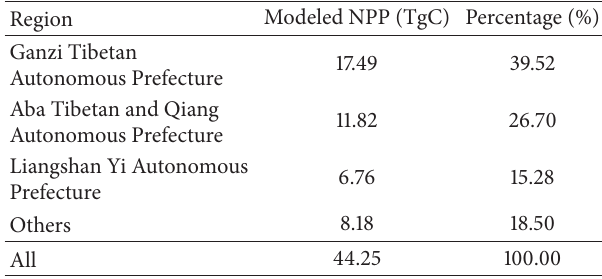
Table 8: The region statistics of NPP for Sichuan grassland in